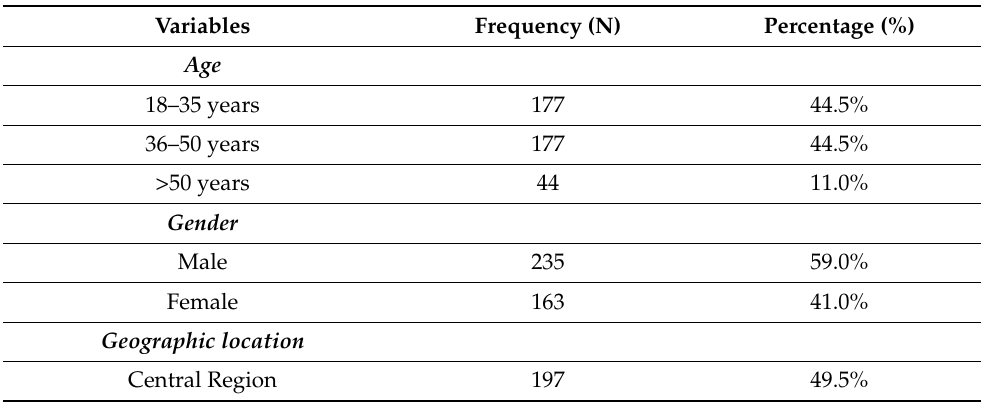
Table 1. Demographic data of study participants (N =